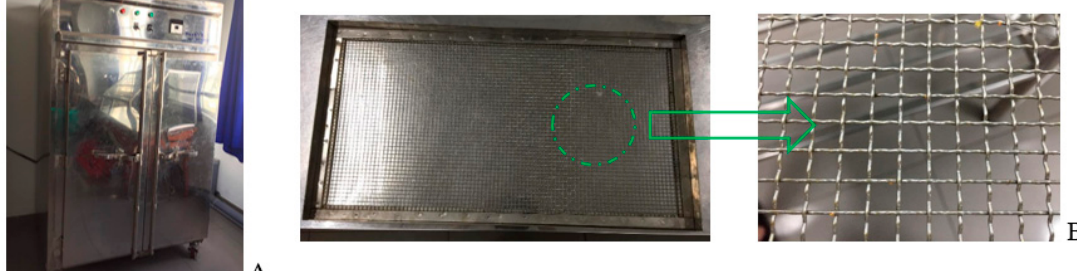
Figure 2. Convection dryer ( A ) and tray ( B ) used in this study.